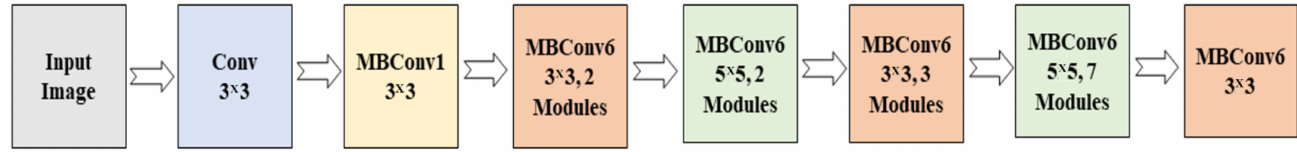
Figure 5. Basic structure of EfficientNet-B0 model.